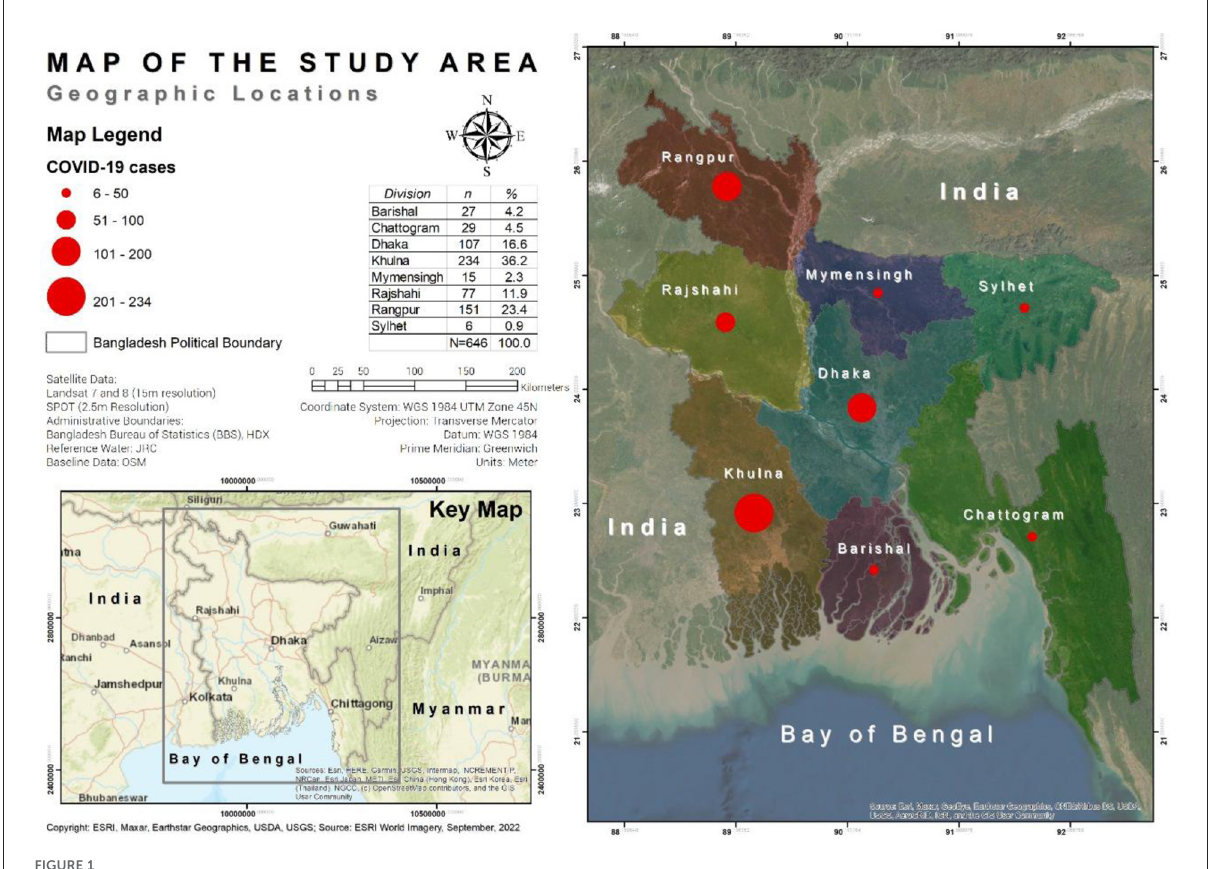
FIGURE1 Map of the study